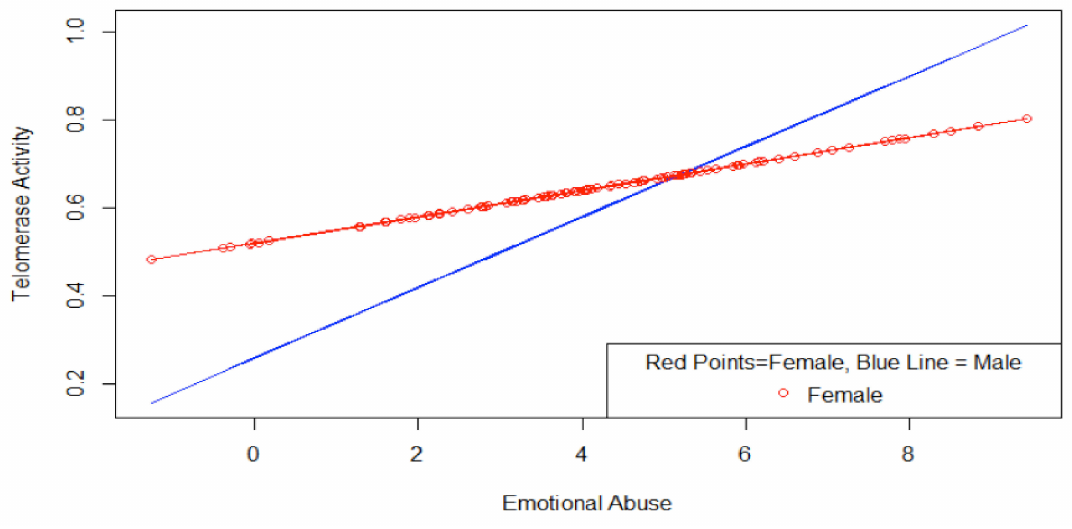
Figure 1. Telomerase Activity and Emotional Abuse. Table 1. Telomerase Activity and Physical, Sexual, and Emotional Maltreatment for Model 1 ( n =